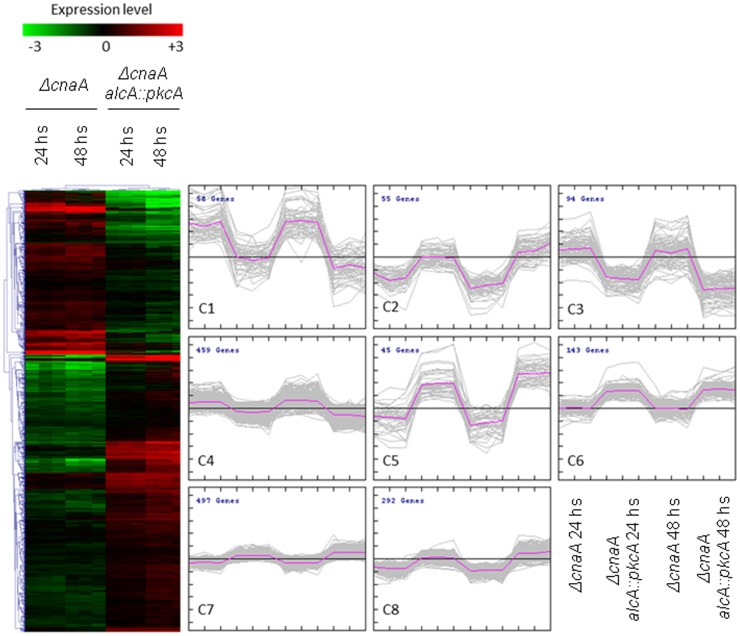
Hierarchal and k-means (KM) clustering of the genes which were differentially (t-test p<0.001) expressed between the Δcna and alcA::pkcA ΔcnaA strains.Microarrays were performed on RNA extracted from both strains when grown in glucose or glycerol and threonine for 24 and 48 hours.